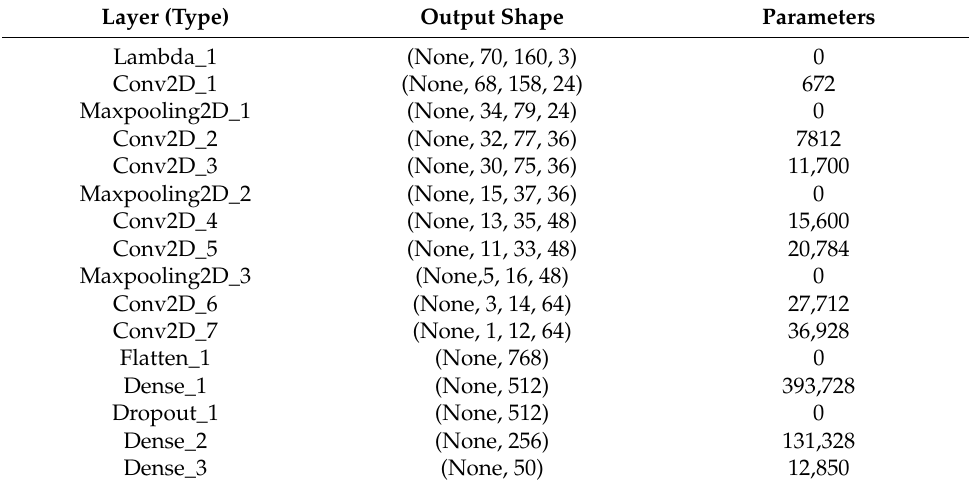
Table 2. Network architecture for LiDAR model.